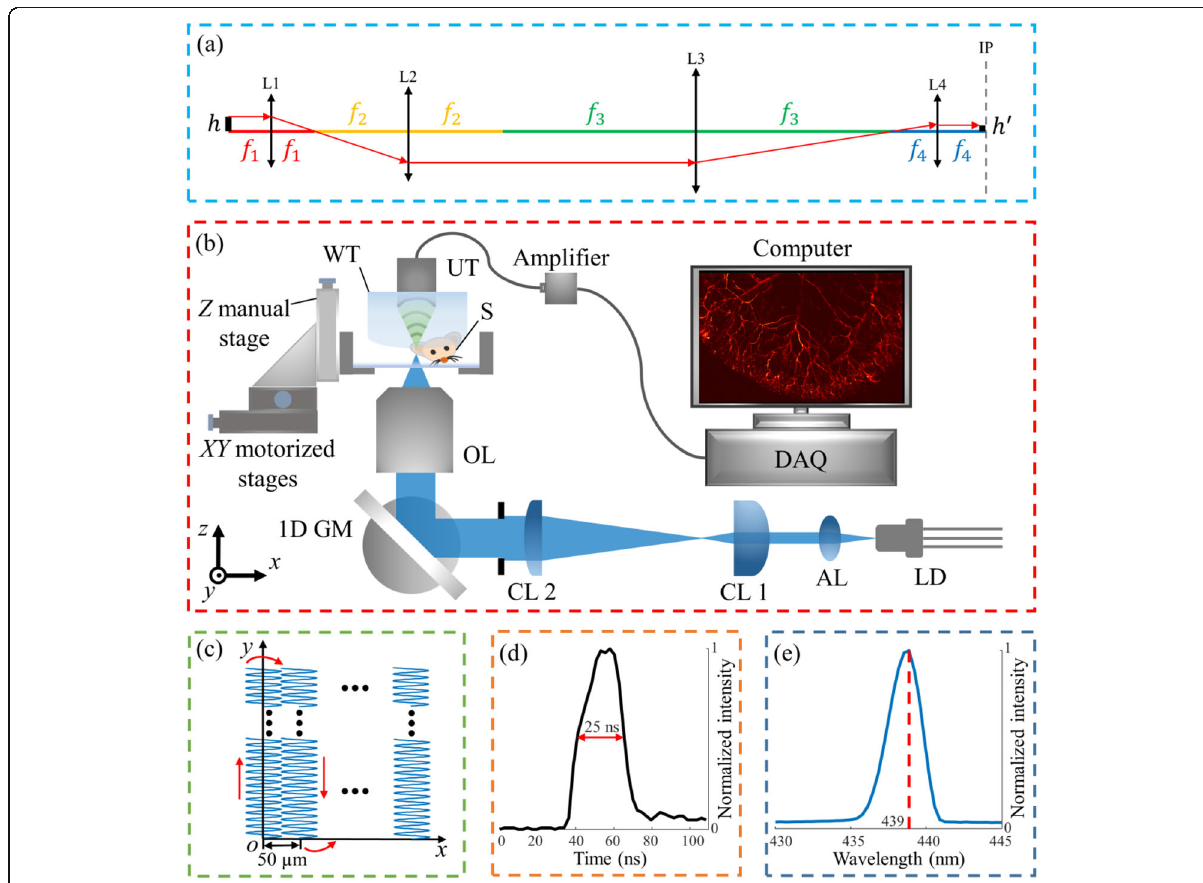
Fig. 1 LD-based PAM system design. a The diagram of the optical system that demagnifies the emitter size of the LD on the image plane; b The schematic of LD-based PAM; c The scanning trajectory of the system; d The waveform of the LD light pulse, showing a pulse width of ~ 25 ns; e The spectrum of the LD light pulse, showing a center wavelength of ~ 439 nm. L: lens; f: focal length; IP: image plane; AL: aspheric lens; CL: cylindrical lens; OL: objective lens; S: sample; UT: ultrasonic transducer; WT: water tank; DAQ: data acquisition